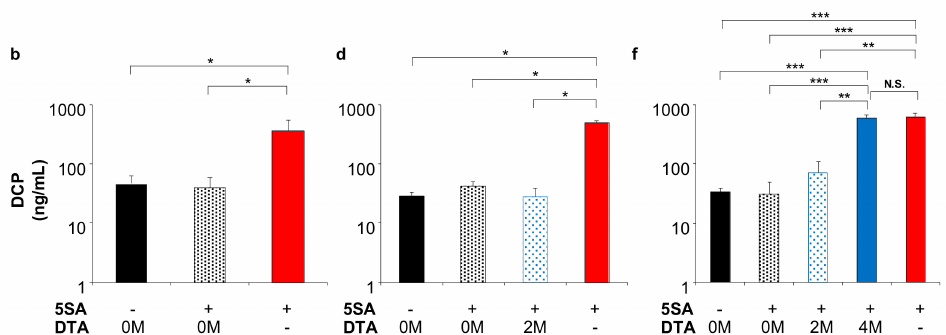
Figure 5. Tumor markers in YAP-induced HCC mice model treated with pAFP–DTA. Serum concentration of AFP and des-gamma carboxyprothrombin (DCP) quantified at 60 days ( a , b ), 120 days ( c , d ), and 180 days ( e , f ) after YAP-expressing plasmid (5SA) delivery with / without the gene therapy of pAFP–DTA by ELISA. The values represent mean ± standard deviation ( n = 5 for each group). * p < 0.05; ** p < 0.01; *** p < 0.001; and N.S. One-way ANOVA followed by Bonferroni’s multiple comparison test. 0 M, 2 M, and 4 M, at 0, 2, and 4 months after the delivery of pAFP–DTA.